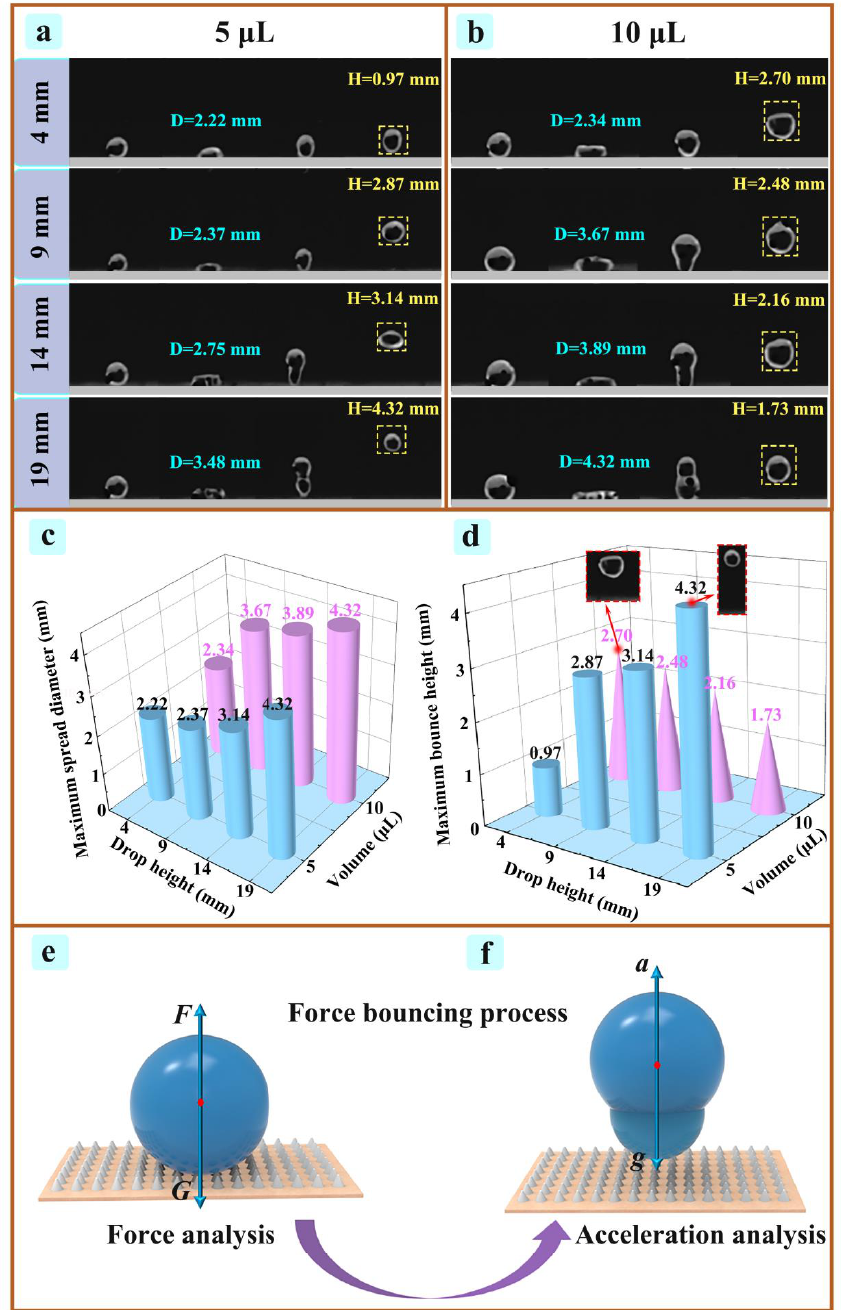
Figure 8. ( a ) Shows the bouncing behavior of 5 µ L droplet falling from different heights to the surface of sample B at room temperature; ( b ) is the bouncing behavior of 10 µ L droplet falling from different heights to the surface of sample B at room temperature; ( c ) is the maximum spreading diameter of the droplet falling from different heights to the surface of sample B under horizontal conditions at room temperature; ( d ) is the maximum bounce height of the droplet falling from different heights to the sample B's superhydrophobic surface under a normal temperature horizontal condition; ( e ) is the force analysis diagram of droplets on the contact sample surface; ( f ) is the acceleration analysis diagram of the droplet in the bouncing